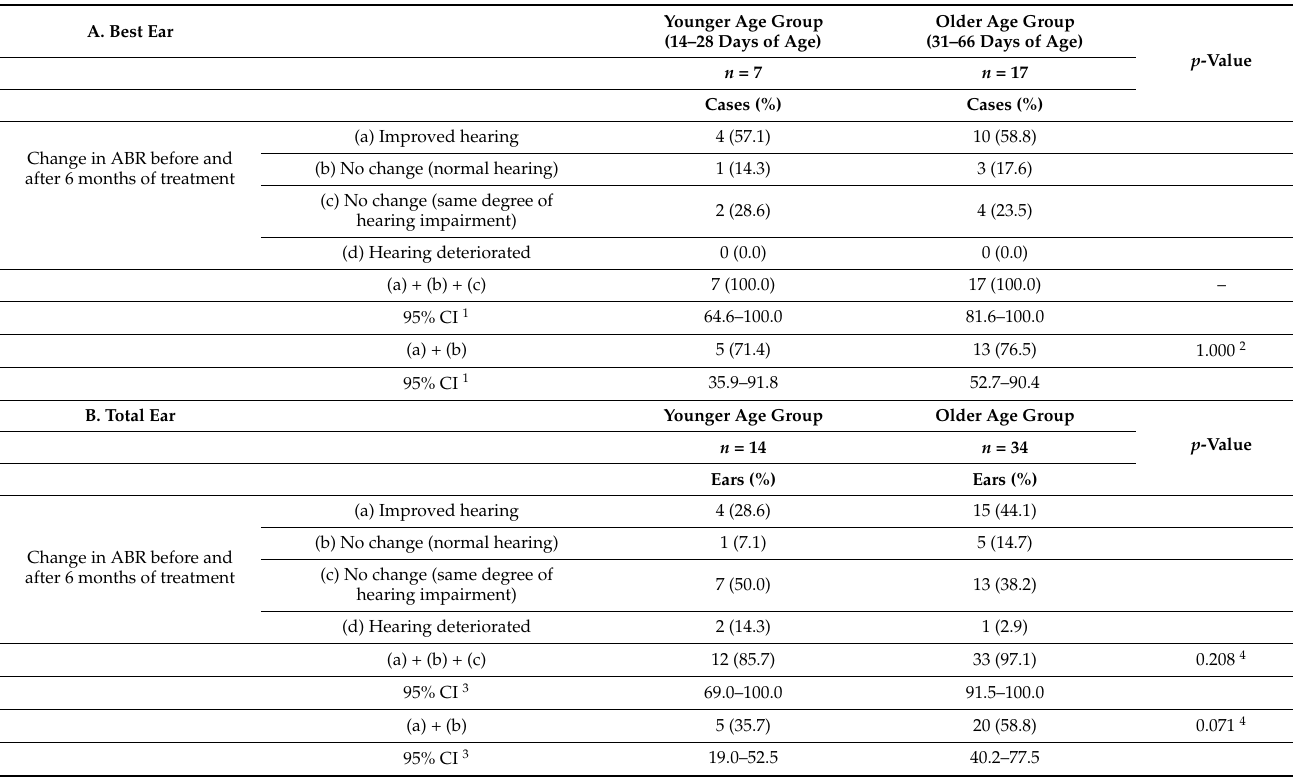
Table 3. Comparisons of best ear and total ear hearing using auditory brainstem responses after 6 months of treatment, based on the age at the start of treatment (younger vs. older